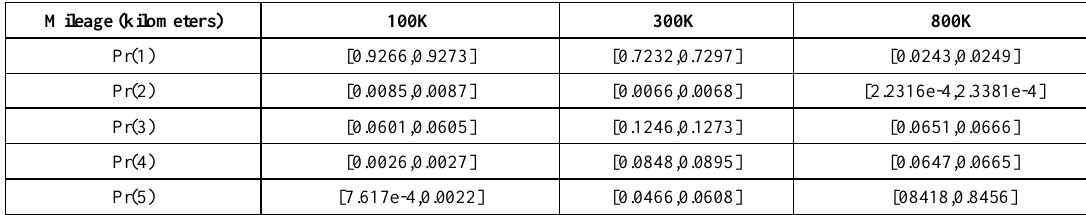
Table 5. Interval system state probabilities with changing k.